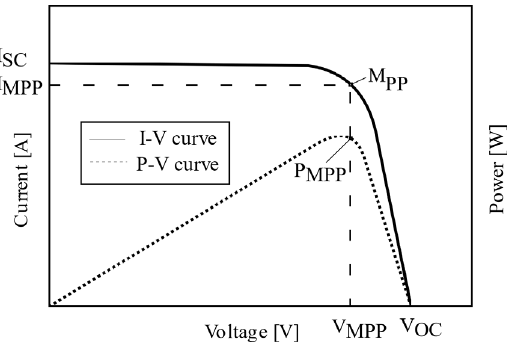
Figure 2. I–V and P–V curves of a solar cell. Source [10], own elaboration.